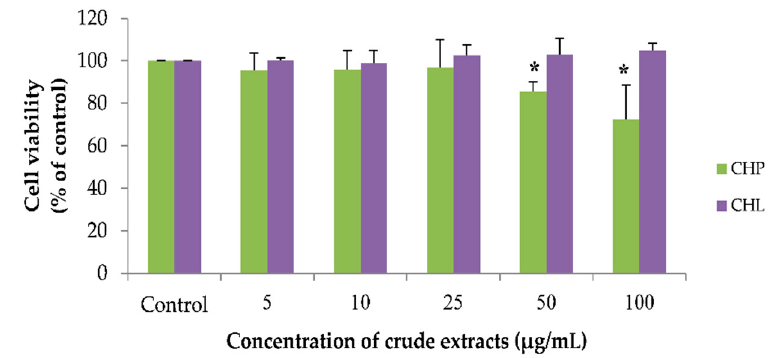
Figure 5. The effect of CHP and CHL on cell viability. Detection of cell viability was performed using an MTT assay. Data are presented as the means ± SD, * p < 0.05 vs. control. p values were 0.018 and 0.030 in groups treated with CHP concentrations of 50 and 100 µg/mL, respectively.